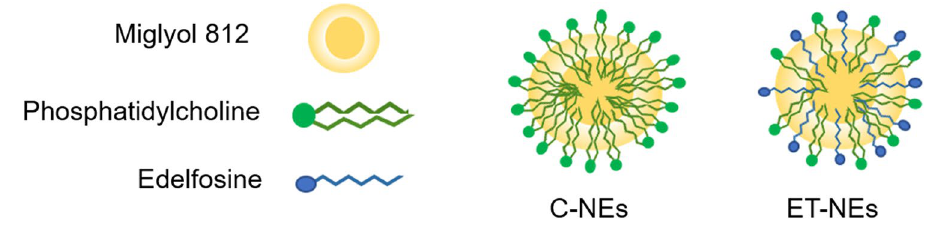
Figure 1. Schematic representation of control (C-NEs) and edelfosine (ET-NEs)